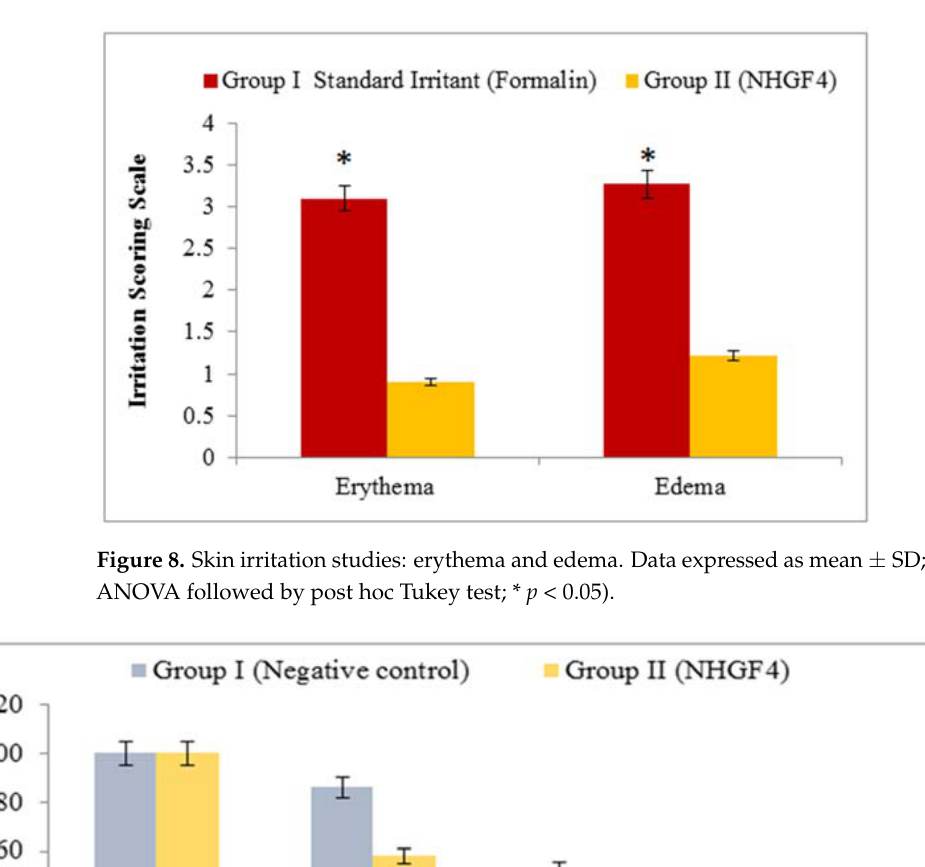
Figure 7. Viscosity of SNP nanoparticles of Citrus limon extract embedded in nanohydrogel formula- tion (NHGF4) at various temperatures (8 ◦ C, 25 ◦ C, 40 ◦ C, and 40 ◦ C RH), respectively.